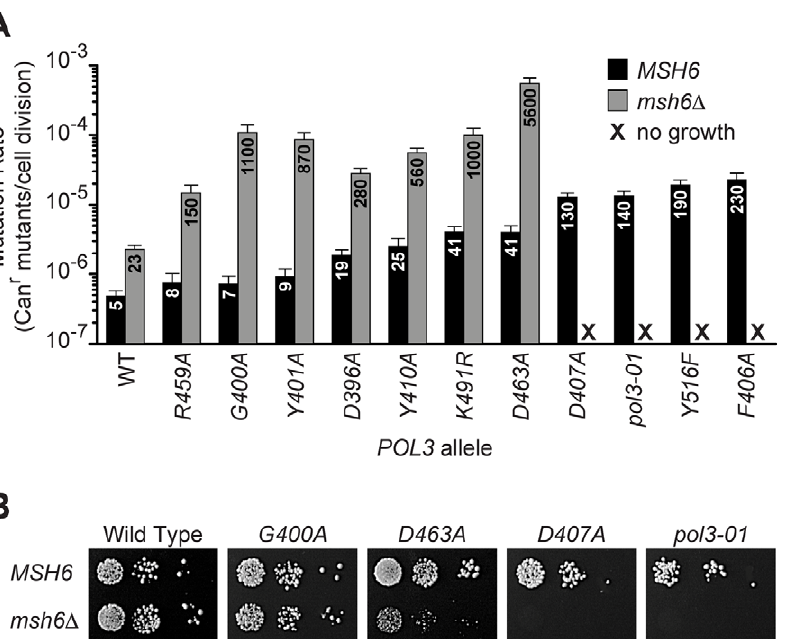
Figure 1. Evidence for a threshold of error-induced extinction. A) Entry into error-induced extinction. Mutated pol3 alleles were introduced into haploid MSH6 and msh6 D yeast by plasmid shuffling (Figure S1), and mutation rates were measured by fluctuation assays and calculated using the maximum likelihood method. Each bar represents the spontaneous mutation rate, expressed as canavanine-resistant (Can r ) mutants per cell division, conferred by a specific POL3 allele in MSH6 or msh6 D cells. Mutation rate values (x 10 2 7 ) are indicated on each column. Error bars show 95% confidence intervals. WT, wild-type POL3 ; black, MSH6 ; gray, msh6 D ; X , no growth. B) Synthetic lethality of strong pol3 mutator alleles with msh6 D . Serial dilutions of haploid yeast containing POL3–URA3 and pol3–LEU2 plasmids were plated on SC FOA medium to select for cells that spontaneously lost POL3–URA3 . Similar numbers of cells ( , 10 5 , 10 4 and 10 3 ) were plated for each set of alleles in the MSH6 and msh6 D strains. Failed growth of msh6 D cells carrying pol3-D407A or pol3-01 indicates synthetic lethality (right two panels). pol3-F406A and pol3-Y516F also failed to support colony formation in msh6 D cells (not shown). Note the small size of pol3-D463A msh6 D colonies.